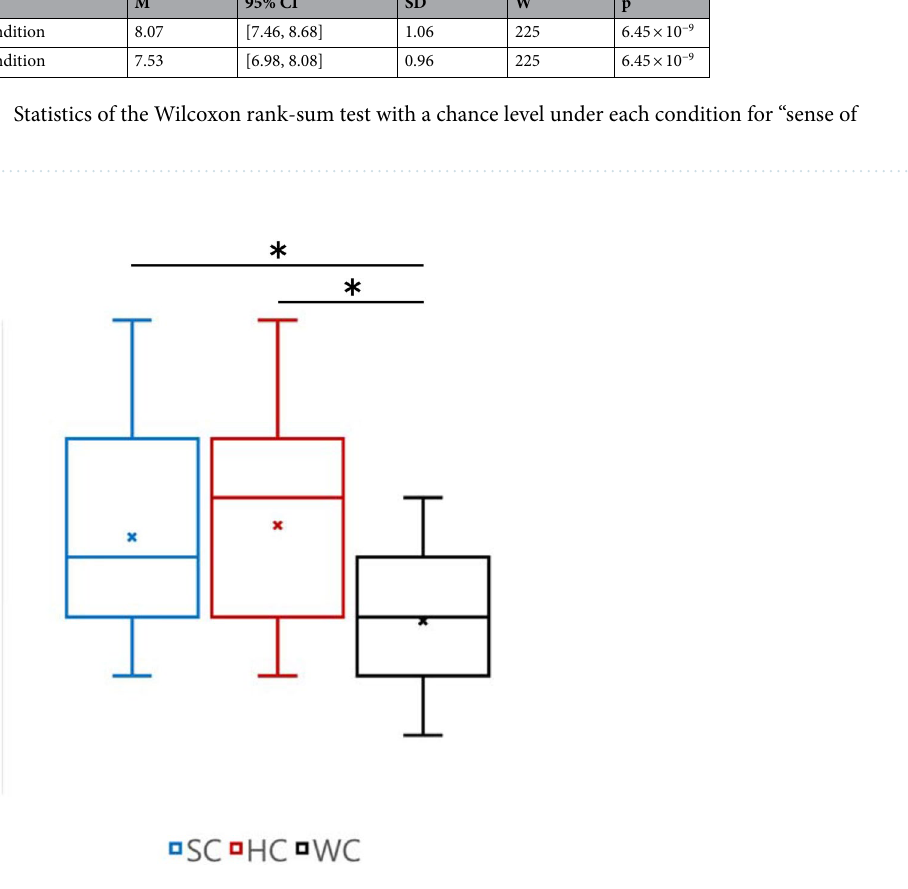
Figure 5. Results of the change in attitude of the participants using the ranking of paintings. The results of Student’s t-test (alpha level of 0.05) obtained using the Bonferroni correction (multiplying the p-value by 3) were used to determine if the amount of change in all conditions was different. We confirmed that the amount of change was significantly higher in SC than that in WC, and higher in HC than that in WC (between SC and WC: t(28) = 2.66, corrected p = 0.0385 < 0.05, Hedge’s g = 0.944; between HC and WC: t(28) = 3.19, corrected p = 0.0103 < 0.05, Hedge’s g = 1.14; between SC and HC: t(28) = − 0.32, corrected p > 1.0, Hedge’s g = − 0.114). (*p <